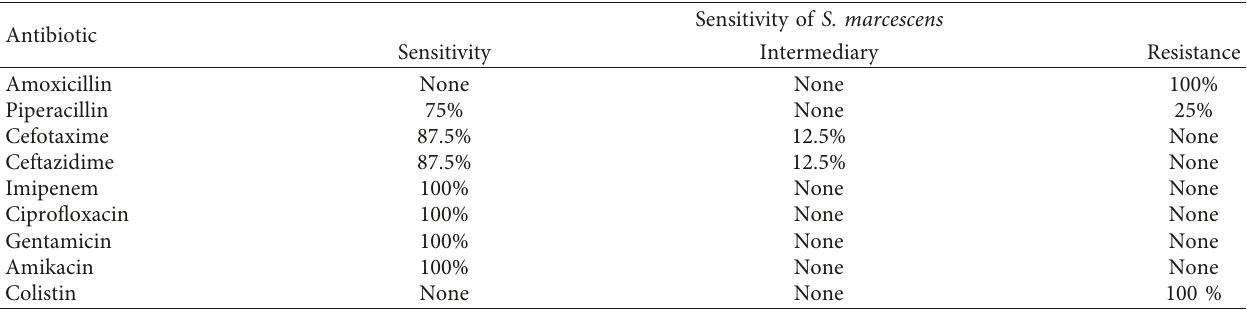
Table 2: Susceptibility to antibiotics of Serratia marcescens.